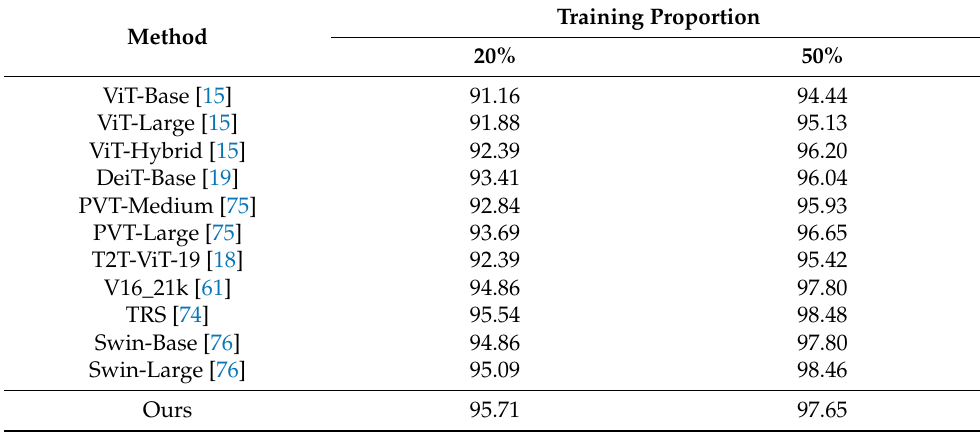
Table 8. Classification accuracy on the AID dataset compared to self-supervised models (OA ± STD).